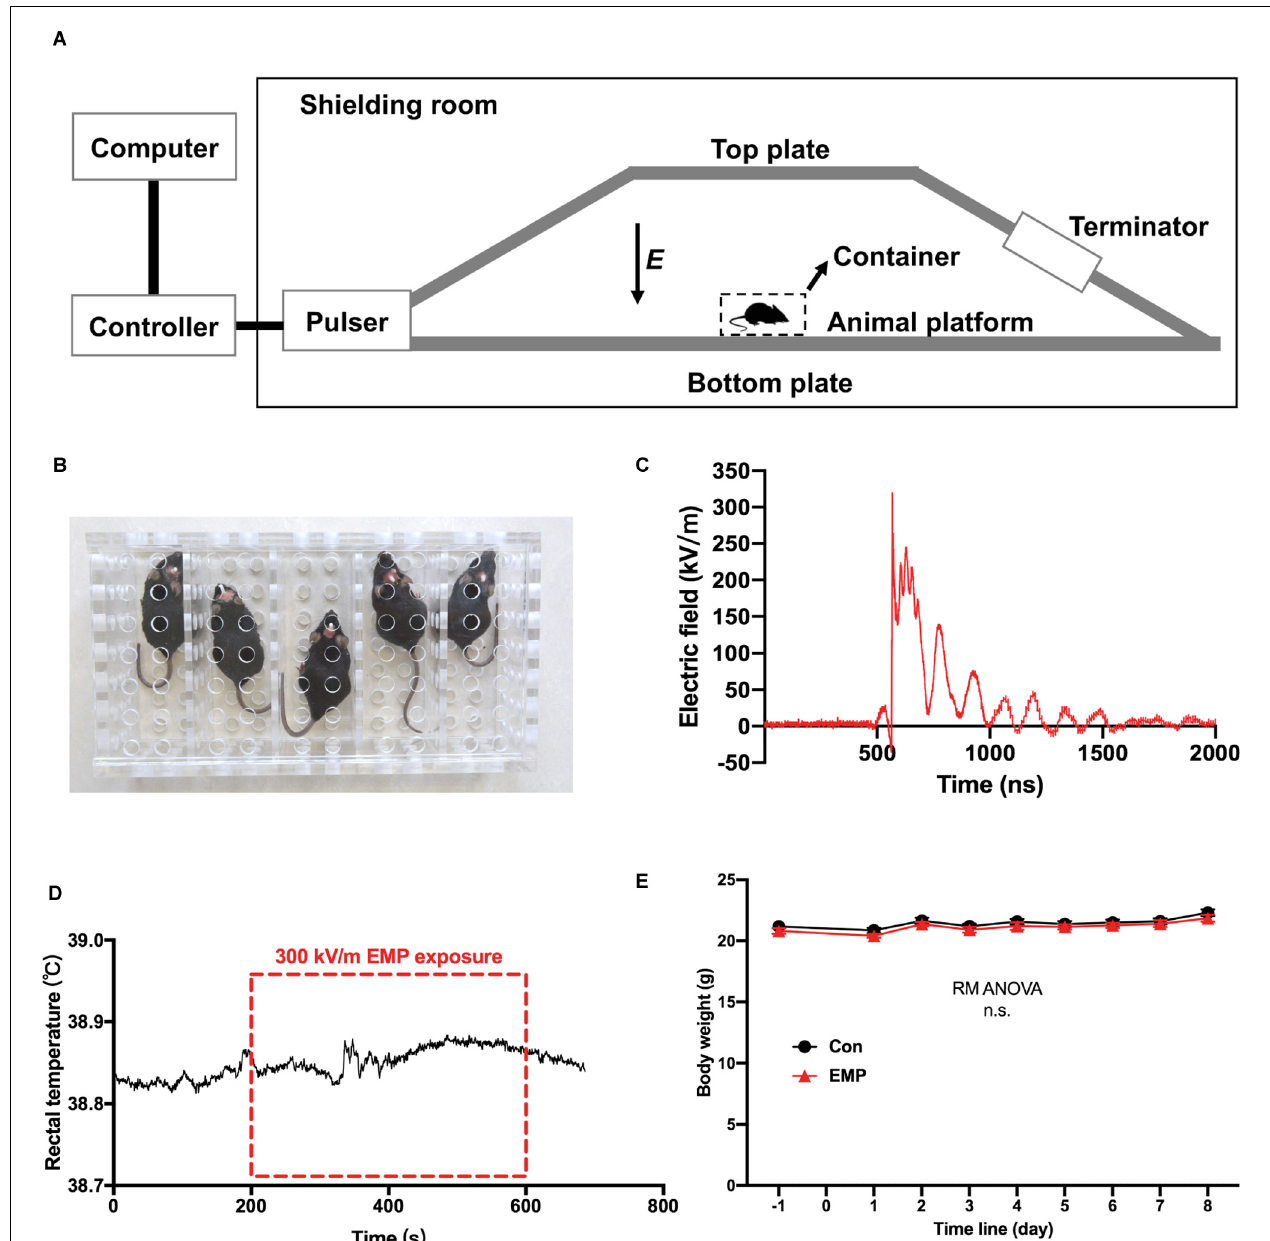
FIGURE 2 | The electromagnetic pulse (EMP) exposure settings and the effects of EMP on the rectal temperature and body weight in mice. (A) Schematic diagram of EMP simulator. (B) Mouse container, a square metal-free box made of resin. (C) Measured electric field waveform. (D) Rectal temperature of mice before, during, and after EMP exposure ( n = 1 mouse). (E) Body weight ( n = 12 mice per group), presented as mean ± SEM. Repeated-measures analysis of variance (RM ANOVA) was used to evaluate the difference between the two curves in (E) . n.s., not